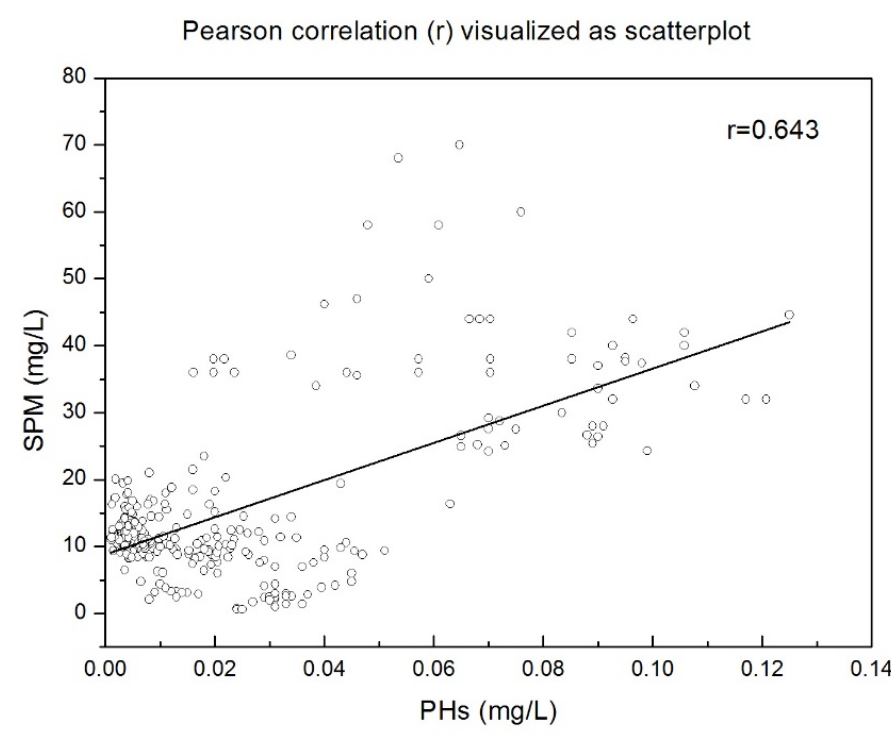
Figure 5. A scatterplot of the SPM levels as a function of the PH concentrations from historical monitoring results.